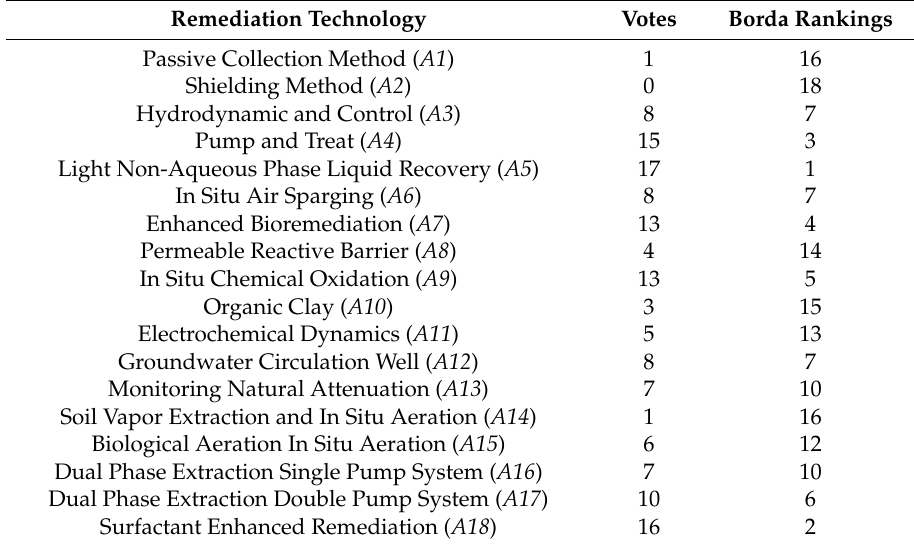
Table 10. Results of Borda ranking